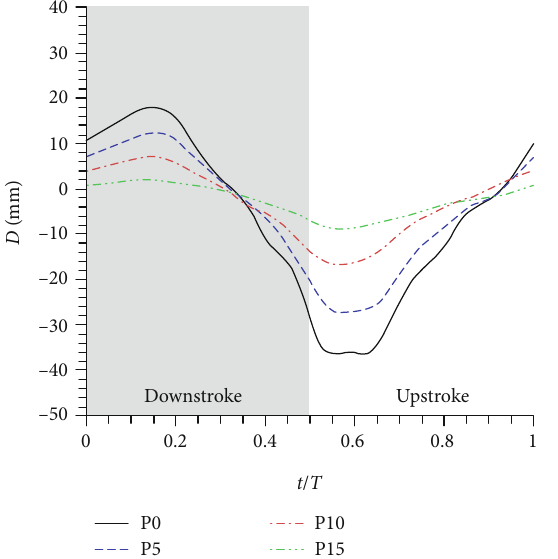
Figure 11: Deformation of the trailing edge compared with that of the leading edge on each